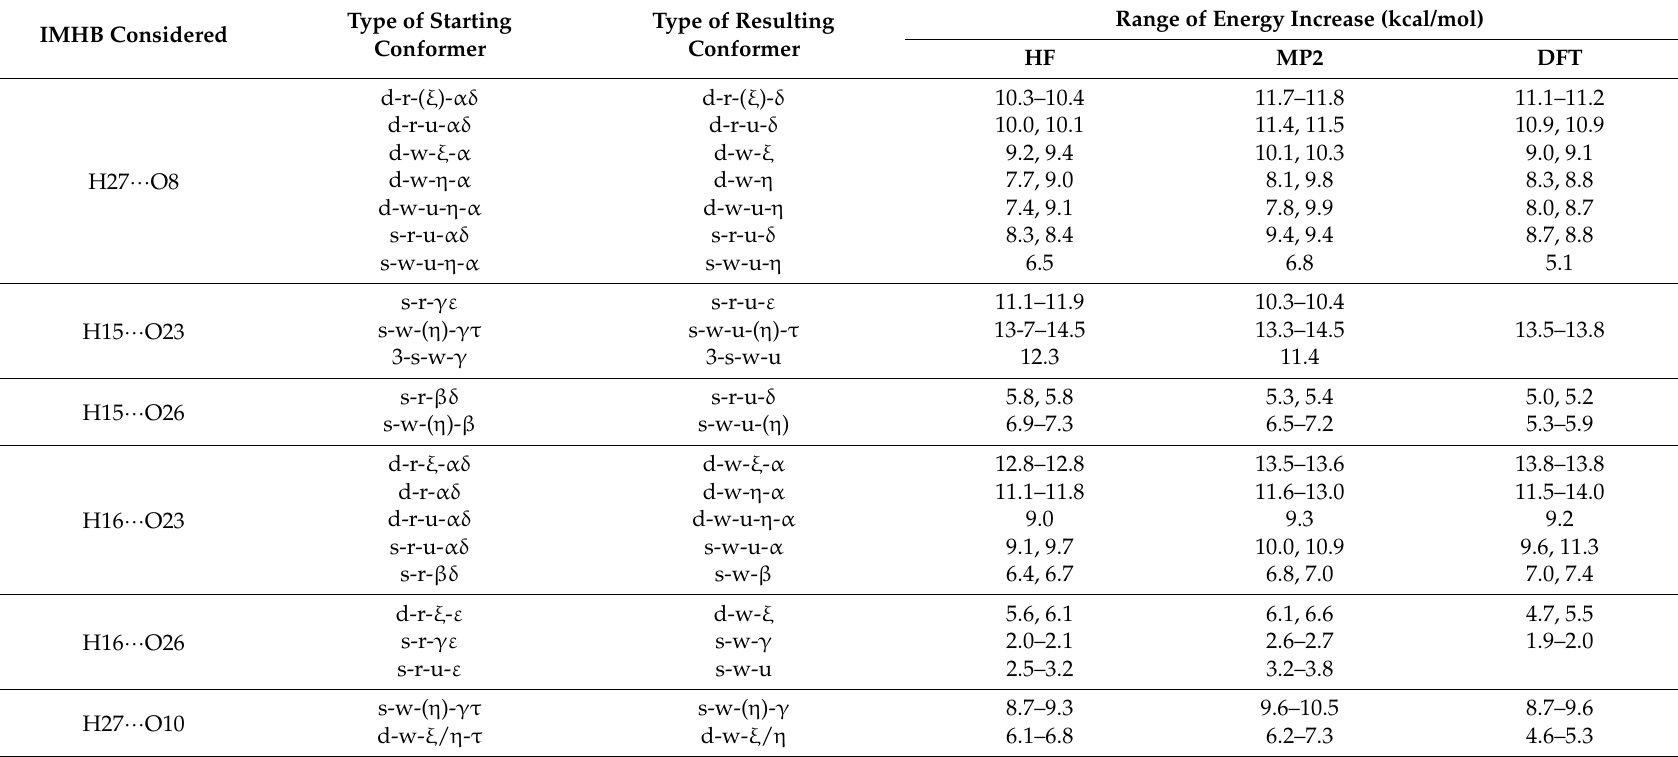
Table 5. Ranges of the energy increase caused by the removal of one intermoiety hydrogen bond (IMHB), according to the type of starting and resulting conformers. The calculation methods are denoted with the following acronyms: HF for HF/6-31G(d,p), MP2 for MP2/6-31G(d,p)/HF/6-31G(d,p) and DFT for DFT/B3LYP/6-31+G(d,p). When only two values are available for a given type, they are both reported, separated by a comma, and in the same sequence in the HF, MP2 and DFT columns. When the two values of a range are identical, it indicates that at least three coinciding values were determined. When a symbol within the acronym denoting a conformer is inserted in parentheses, it means that the range is valid both when the characteristic denoted by that symbol is present and when it is not; for instance, the acronym d-r-( ξ )- αδ indicates that the given range applies both to the d-r- ξ - αδ conformers and to the d-r- αδ conformers. An acronym with both symbols referred to a given characteristics informs that the range is valid for both types of conformers; e.g., d-w- ξ / η - τ indicates that the given range applies both to the d-w- ξ - τ conformers and to the d-w- η - τ